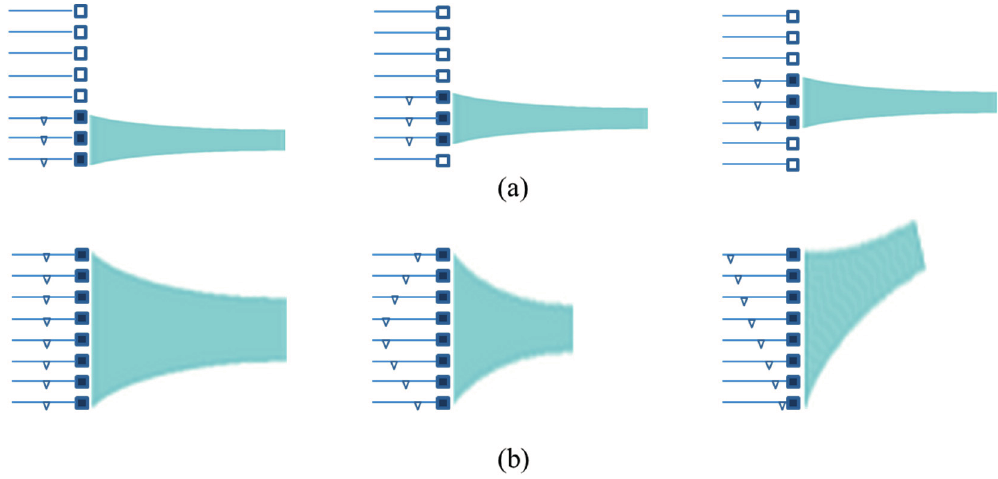
Figure 9. Schematic diagrams of ( a ) electronic scanning of 1-D linear arrays; (b ) electronic focusing and steering of 1-D phased linear